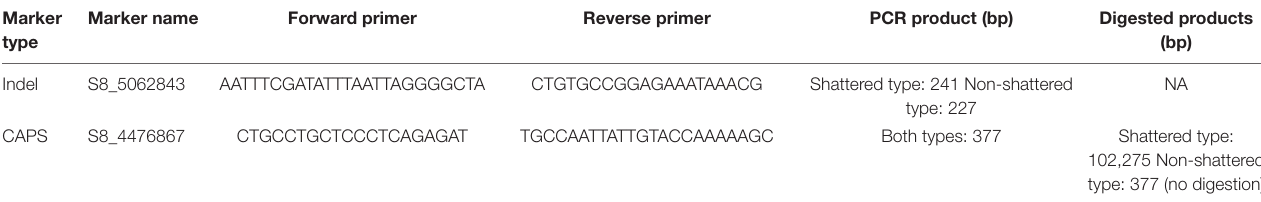
TABLE 7 | The markers developed to differentiate shattered and non-shattered capsule